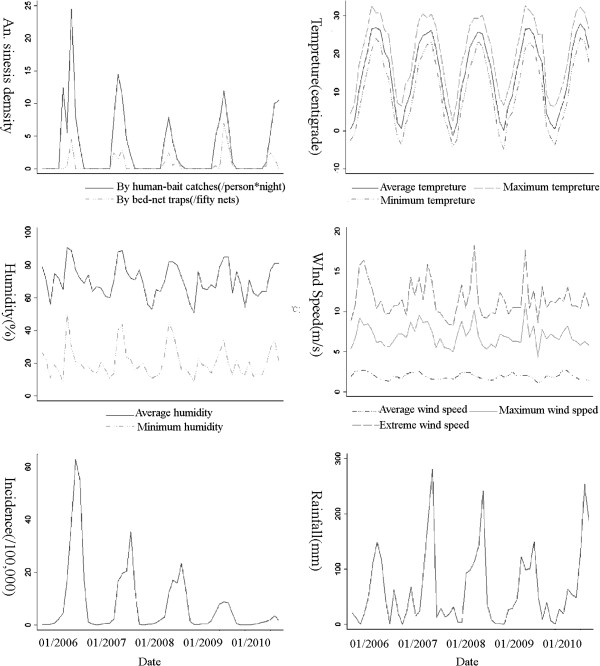
Time series plots of malaria incidence and influencing factors from 2006 to 2010 in Yongcheng prefecture, Henan. Influencing factors include Dbait, Dnet, Tavg, Tmax, Tmin, Havg, Hmin, R, Wavg, Wmax, We.